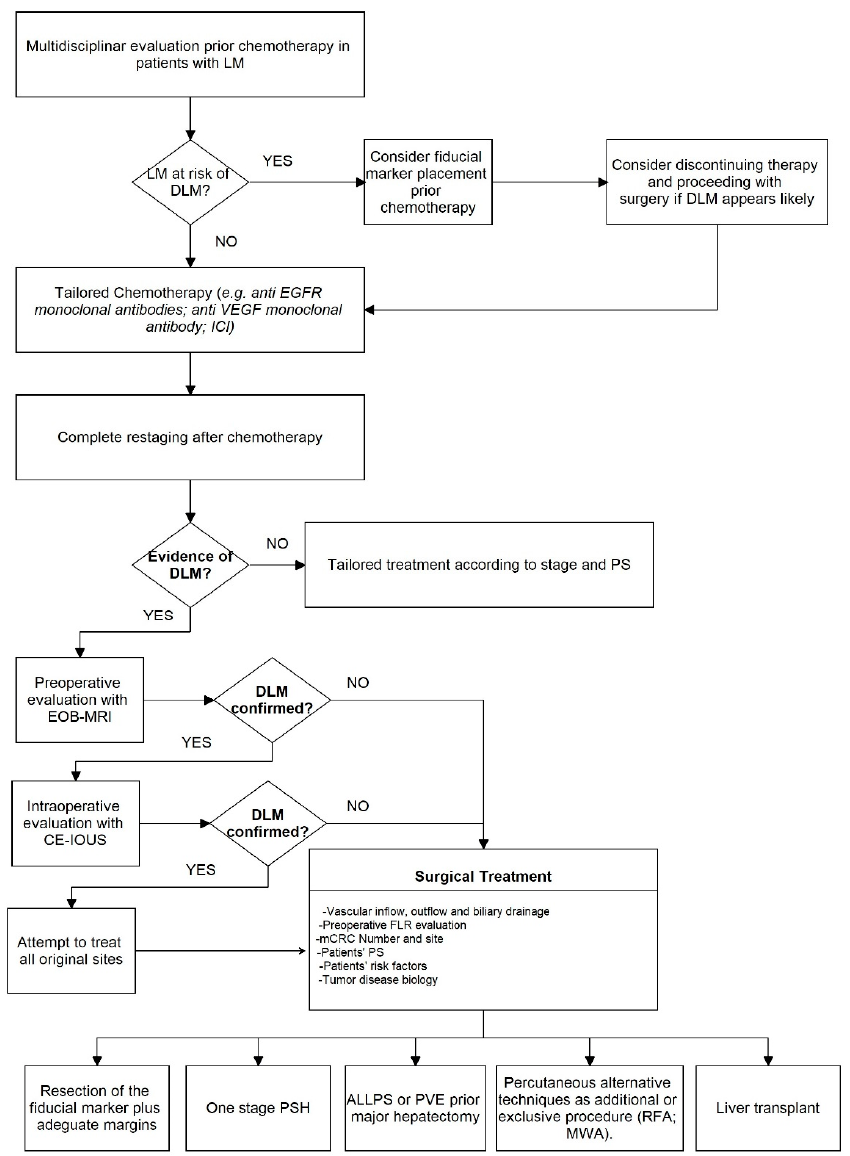
Figure 1. Preoperative surgical algorithm for DLM. LM: liver metastasis; DLM: disappearing liver metastasis; EGFR: epidermal growth factor receptor; VEGF: vascular endothelial growth factor; ICI: immune checkpoint inhibitor; EOB-MRI: gadoxetic acid-enhanced magnetic resonance imaging; CE-IOUS: contrast-enhanced intraoperative ultrasound; FLR: future liver remnant; PS: performance status; PSH: parenchymal-sparing hepatectomy; ALLPS: associating liver partition and portal vein ligation for staged hepatectomy; PVE: portal vein embolization; RFA: tadiofrequency ablation; MWA: microwave ablation; mCRC: metastatic colorectal